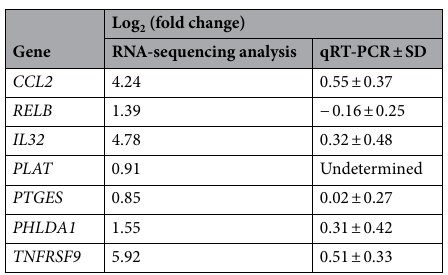
Table 1. The comparison of fold-changes in the expression of the selected 7 DEGs in SH-SY5Y cells transfected with 2BmCherry determined by RNA-sequencing analysis and qRT-PCR